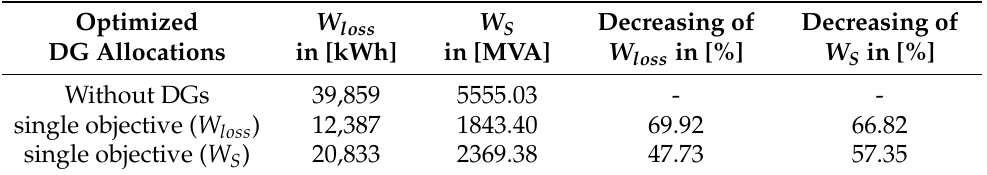
Table 8. Results for optimal solutions of Opt 3 optimization model for different objective functions (W2 workflow).